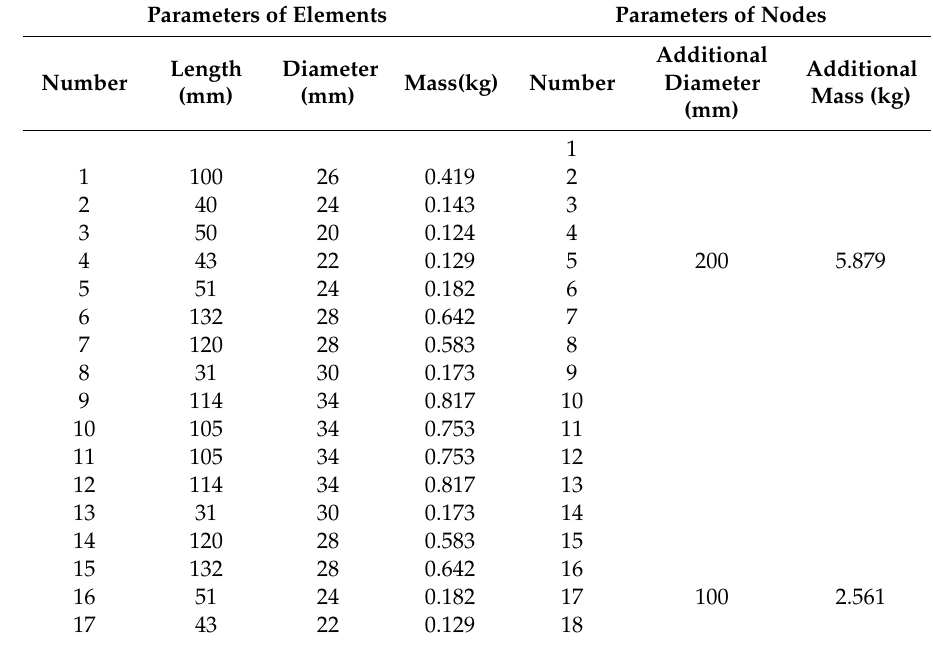
Table 2. Nodes and elements of